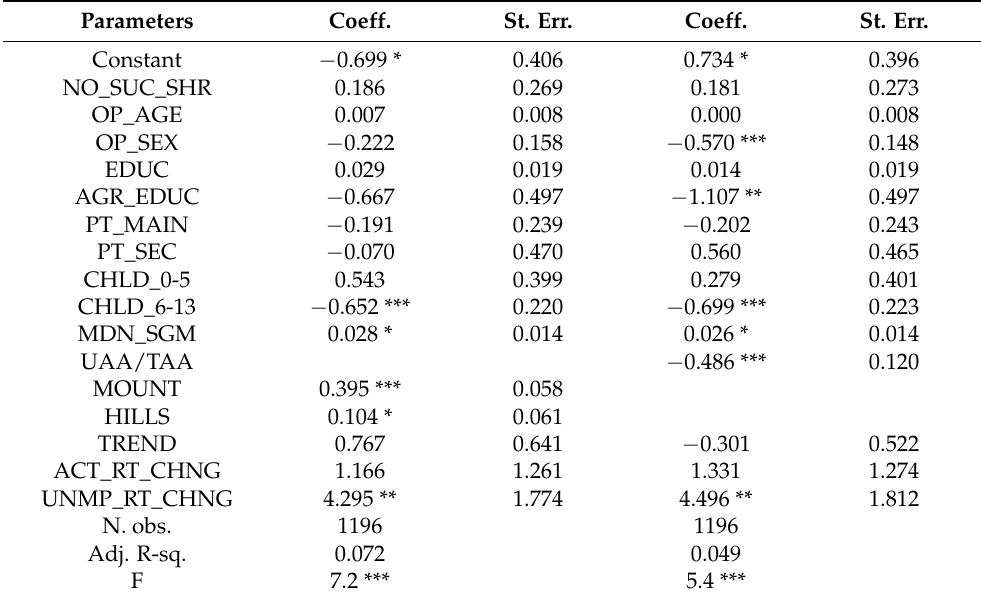
Table A4. Parameter estimates of the TAA decrease rate model using the all farms database. Parameters Coeff. St. Err. Coeff. St.